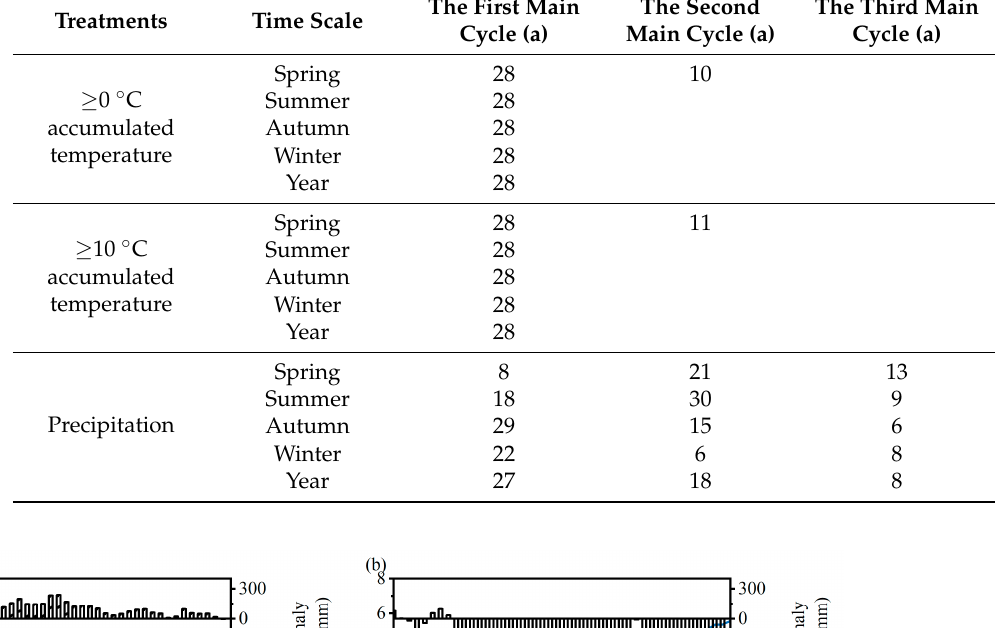
Table 2. The main cycles of water and thermal elements in Henan Province from 1978–2021 under different time scales.